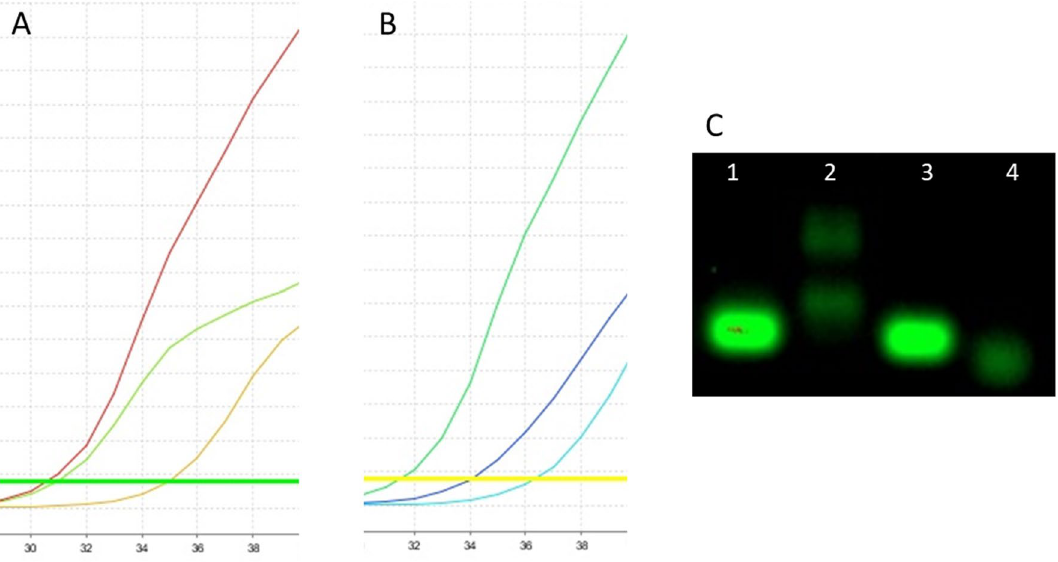
Figure 5. Real-time PCR amplification curves and amplicons of SARS-CoV-2-positive and negative samples without UDG activation followed by separation with 2% agarose gel electrophoresis. ( A ) Amplification curve produced using the hCOVassay1 primer of SARS-CoV-2–positive (red line) and negative control (green and yellow line) samples. ( B ) Amplification curve produced using the hCOVassay2 primer of SARS-CoV-2- positive (green) and negative control (indigo and light blue lines) samples. ( C ) Amplicons after separation on a 2% agarose gel by electrophoresis. Lane 1: amplicon of a SARS-CoV-2-positive sample obtained using the hCOVassay1 primer (111 bp). Lane 2: SARS-CoV-2-negative sample amplified using hCOVassay1 primer. Lane 3: SARS-CoV-2–positive sample amplified using the hCOVassay2 primer (102 bp). Lane 4: SARS-CoV-2- negative sample amplified using the hCOVassay2 primer. The gels were cropped for improving the quality and clarity of image. Full gels are presented in Supplementary Fig.